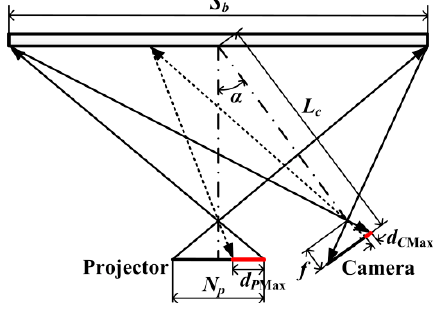
Figure 12. The model for calculating d P Max .